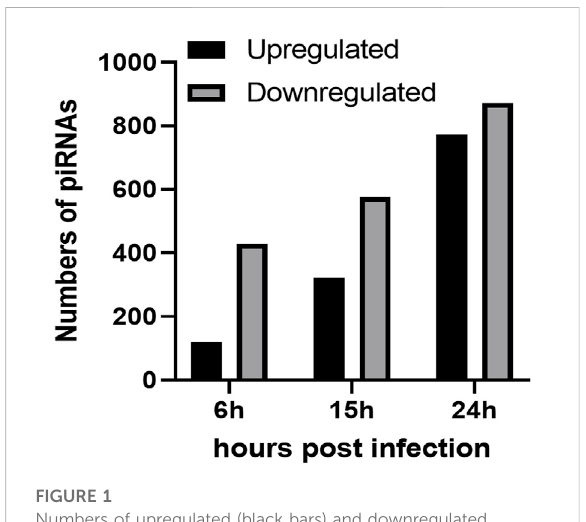
FIGURE 1 Numbers of upregulated (black bars) and downregulated (grey bars) piRNAs in RSV infected SAE cells at 6, 15 and 24 h p. i. Compared to the mock (uninfected) SAE cells. Data is representative of six replicates for each time point with p <